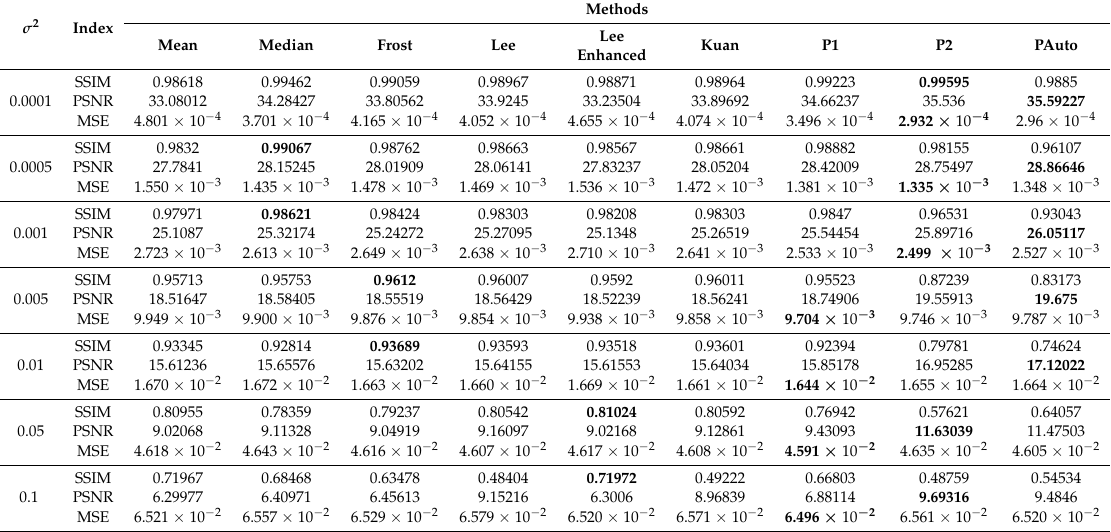
Table 1. Results of speckle noise reduction for different algorithms. The best results of each case among these methods are denoted by boldface.